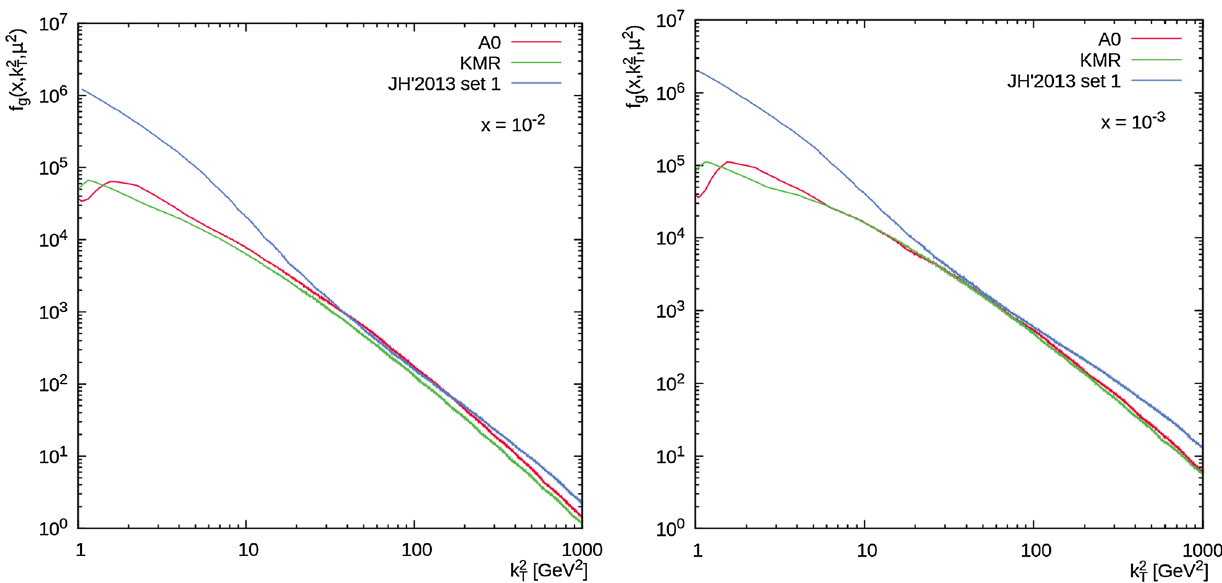
Fig. 1 The TMD gluon densities in the proton calculated as a function of the gluon transverse momentum k 2 fractions x = 10 − 2 (left panel) or x = 10 − 3 (right panel) and μ 2 = 10 4 GeV